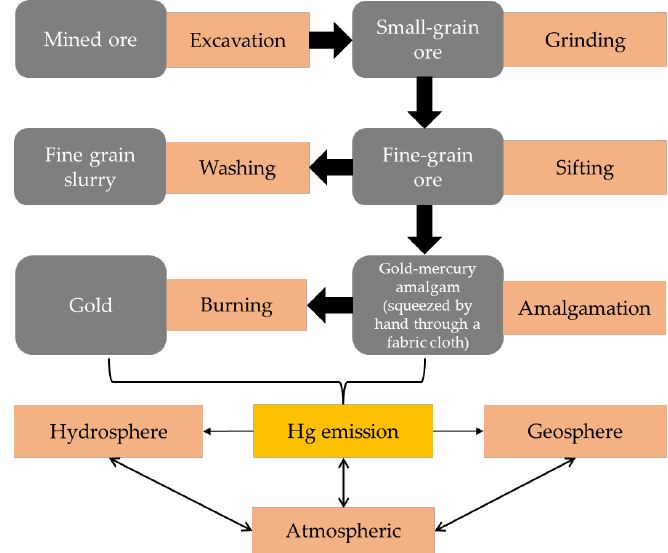
Figure 3. Flow chart showing general ASGM processes.